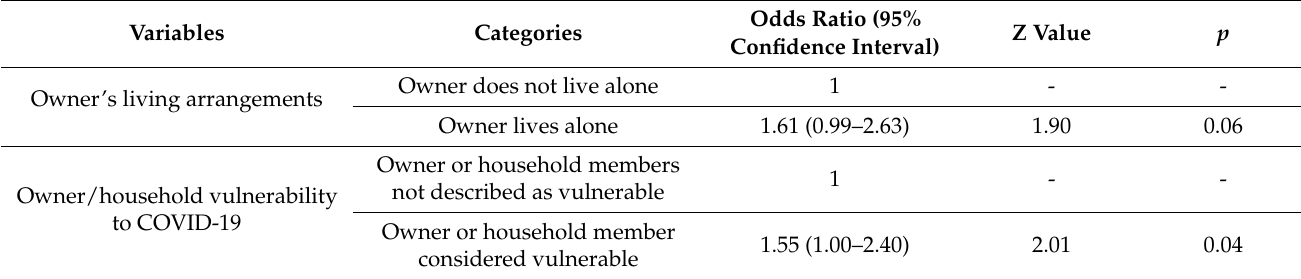
Table 4. Multivariable logistic regression model for dog’s reduction in total weekly dog walking duration during